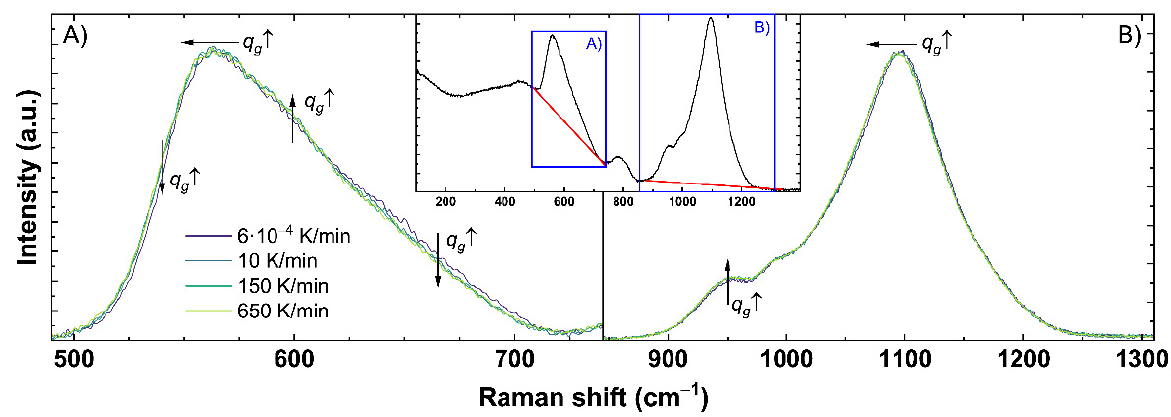
Figure A1. Detailed analysis of the obtained Raman spectra for ( A ) the range of the main band and ( B ) the Q-range. An example of the complete untreated Raman spectrum is shown in the inset. The red line displays the used baseline correction for each range indicated by the blue boxes. Effects of higher cooling rates ( q g ↑ ) are indicated by the shown arrows: horizontal for shifts and vertical for intensity changes in the corresponding direction of the displayed arrow.